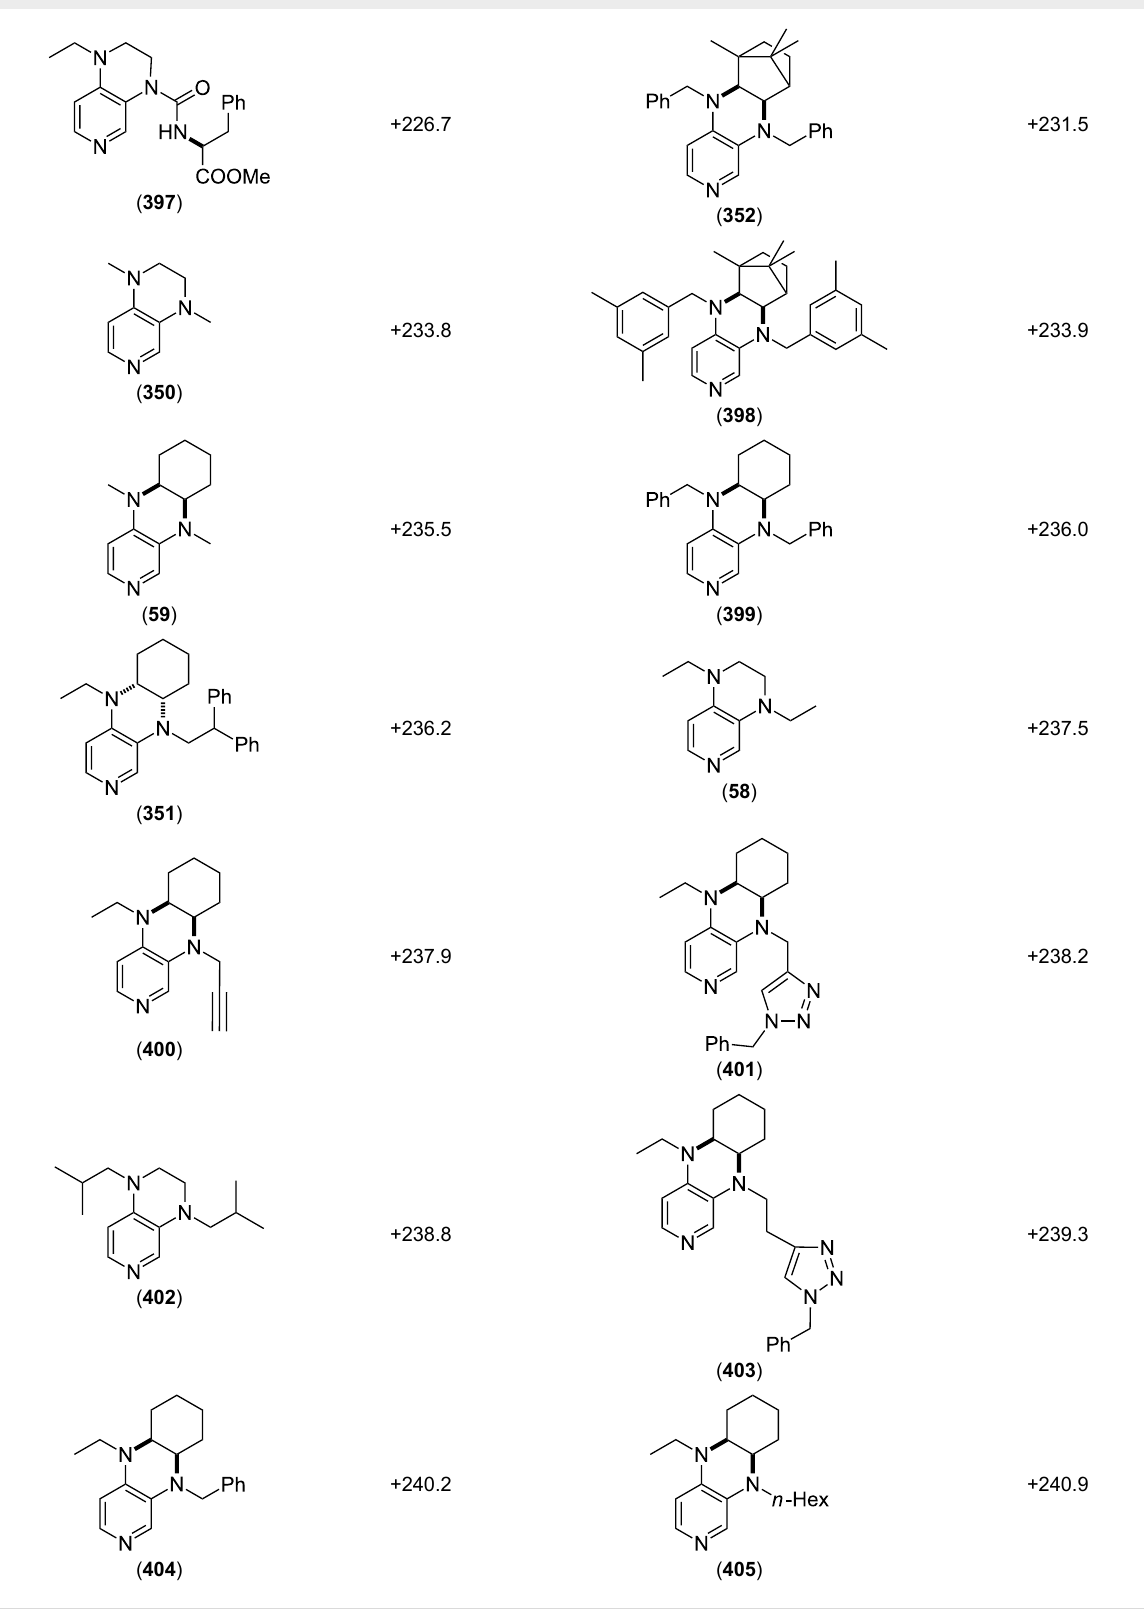
Table 14: ACA values of 3,4-diaminopyridines, ordered by increasing ACA values.